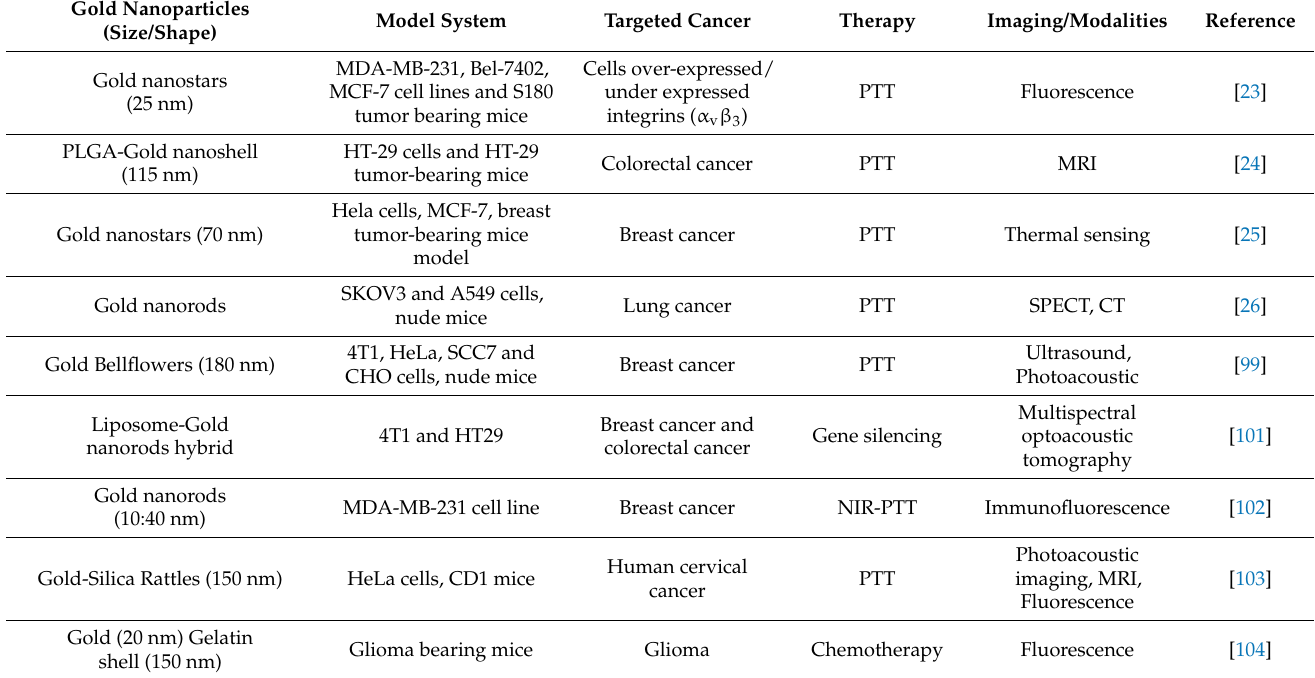
Table 2. Studies on using anisotropic gold nanoparticles in cancer nanotheranostics and their respec- tive in vitro/in vivo safety